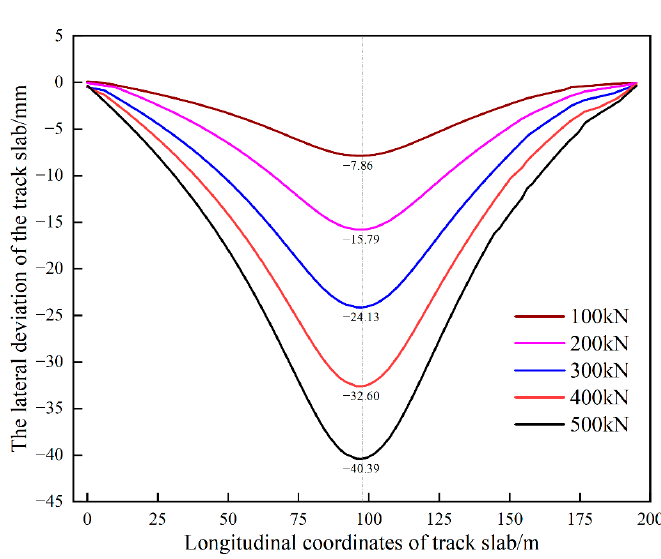
Figure 10. Lateral deviation curves of different jacking forces under multi-point jacking.